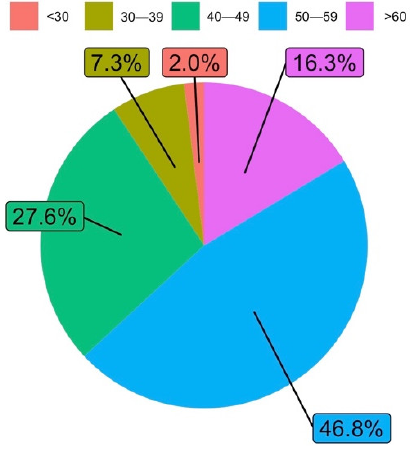
Figure 3. Age groups (answers to Q1.b).